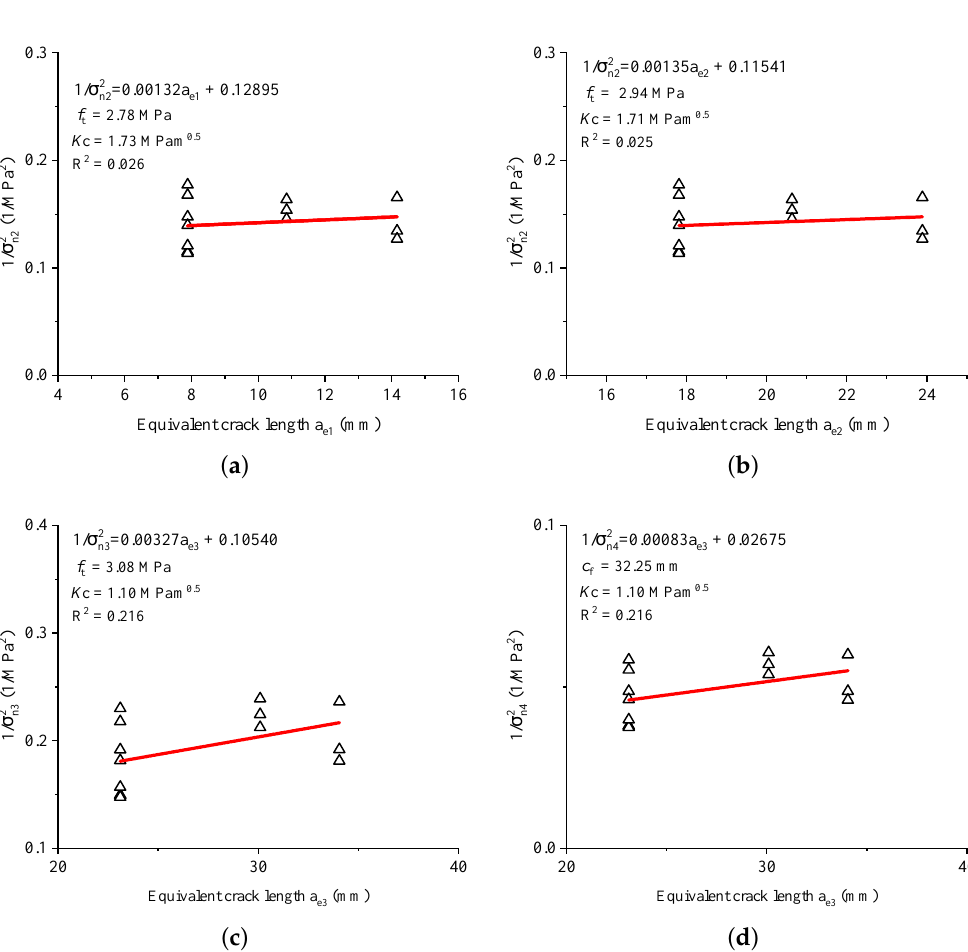
Figure 7. Test results in [31] and the corresponding fitted curves of ( a ) Hu-Guan’s boundary effect model with β 1 = 1, ( b ) modified Hu-Guan’s boundary effect model with β 1 = 1, ( c ) Koval-Gao’s size and boundary effect model and ( d ) Bažant’s Type 2 size effect law.